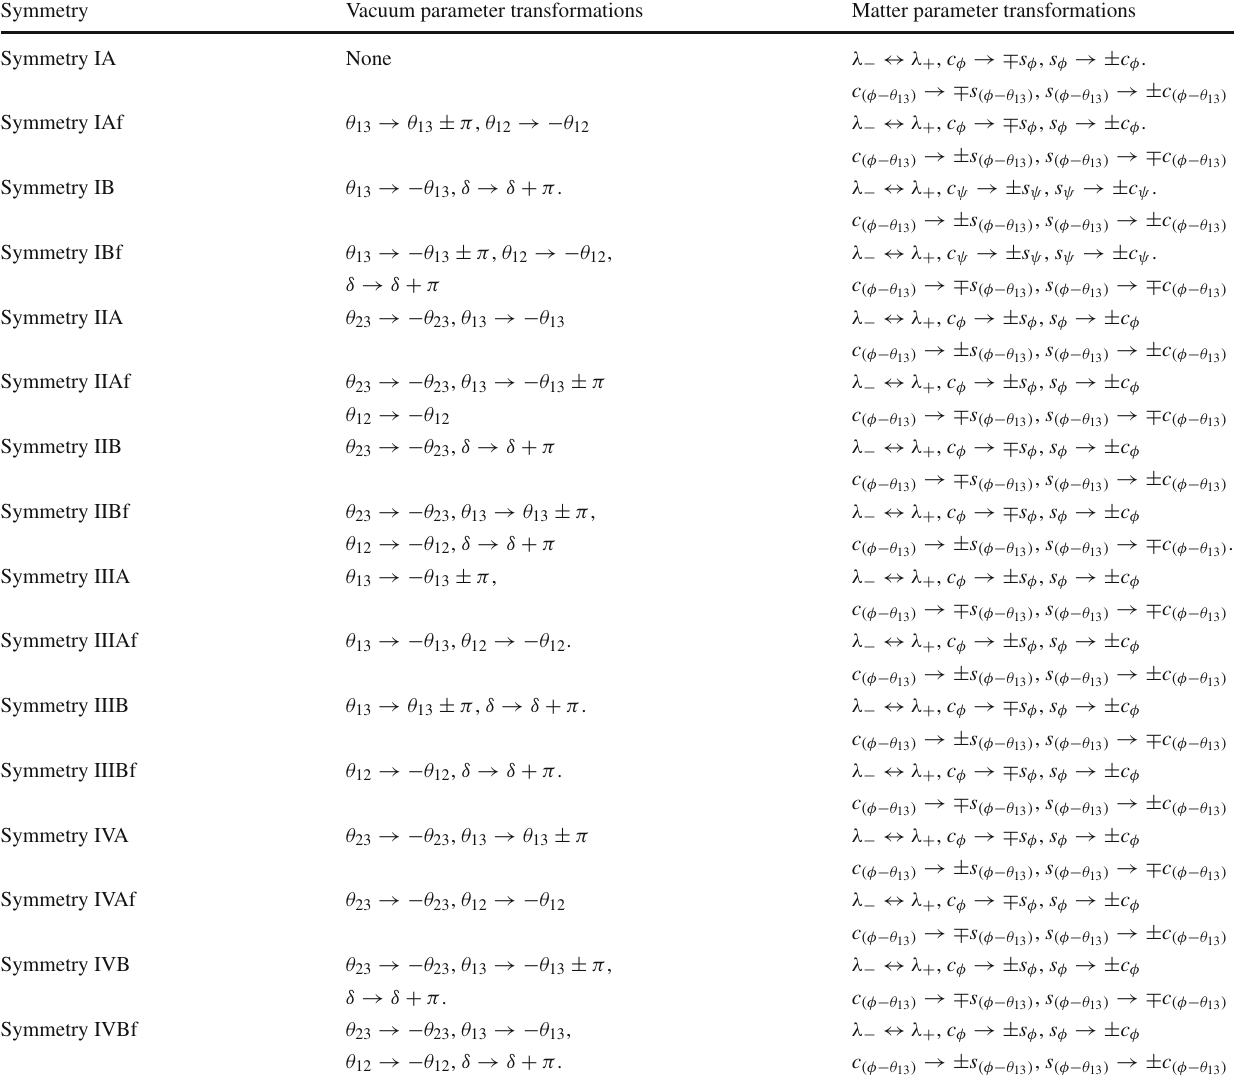
Table 1 Summary of the reparametrization symmetry in the helio- perturbation theory [19]. The symmetry denoted as e.g., “Symmetry X” in this Table is called as “Symmetry X-helioP” in the text,